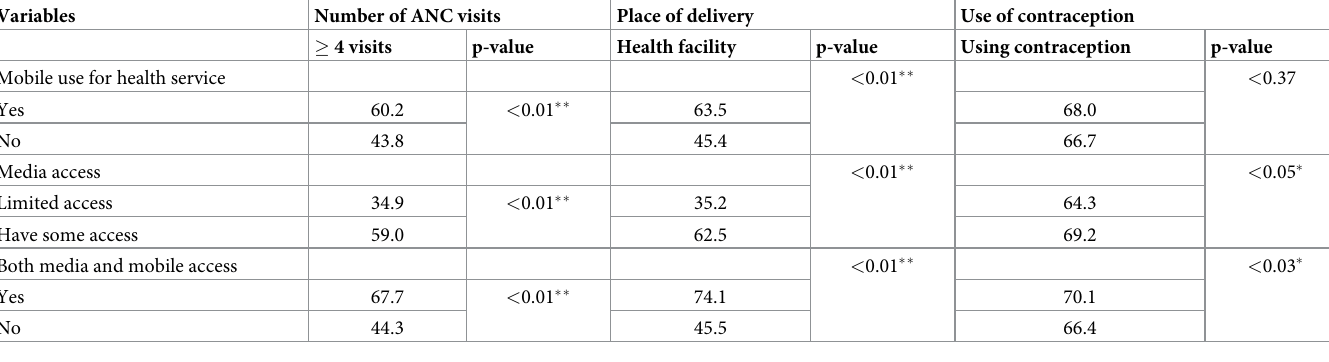
Table 3. Percentage distribution of outcome variables in response to main exogenous